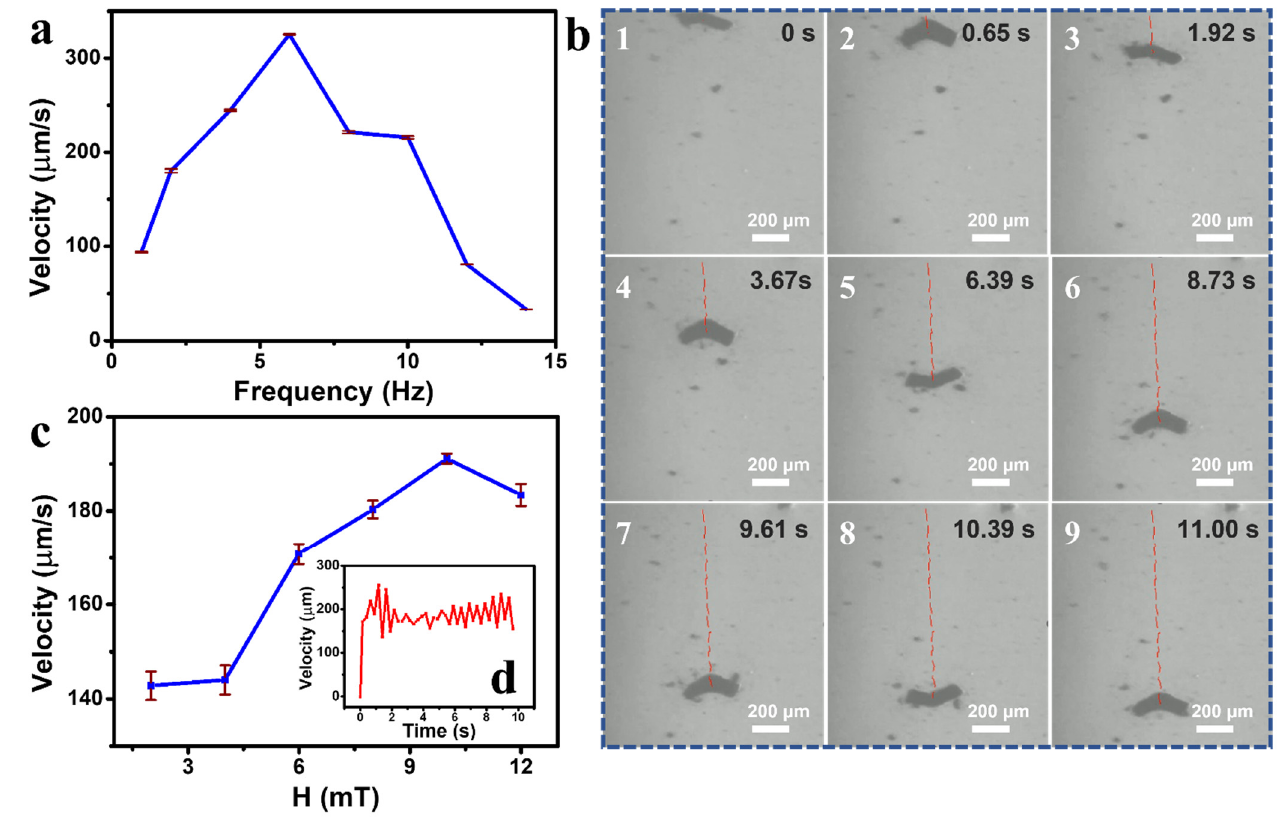
Figure 6. ( a ) Velocity profile of the chitosan-based microrobots from 1 to 14 Hz. ( b ) Positions of a representative microrobot moving at 1 Hz for 11 s. ( c ) Velocity profile of the microrobots with the RMF intensity increasing from 2 to 12 mT at 2 Hz. ( d ) The inset figure shows the velocities of the microrobot at 12 mT for 10 s.